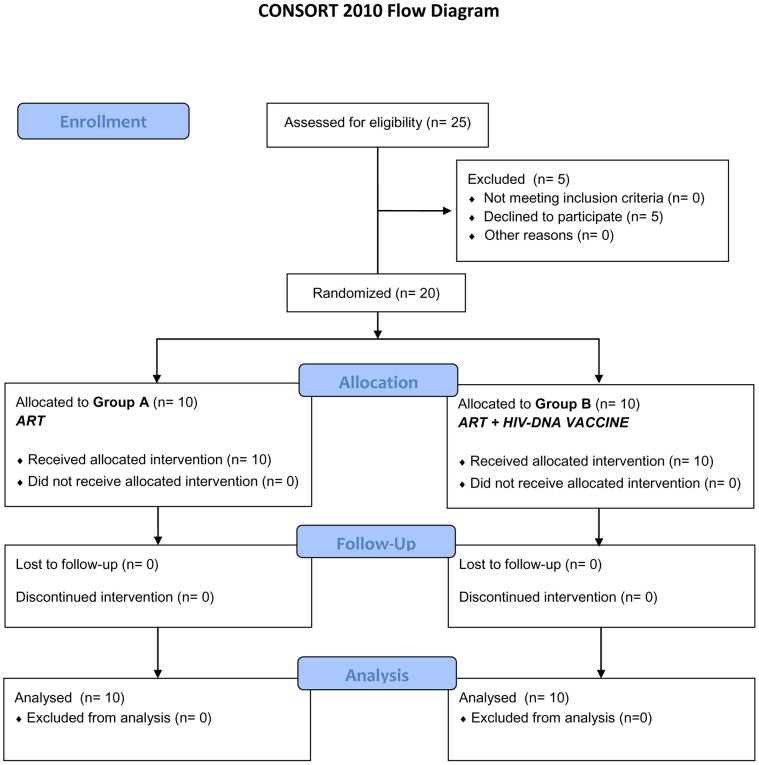
CONSORT 2010 flow diagram.